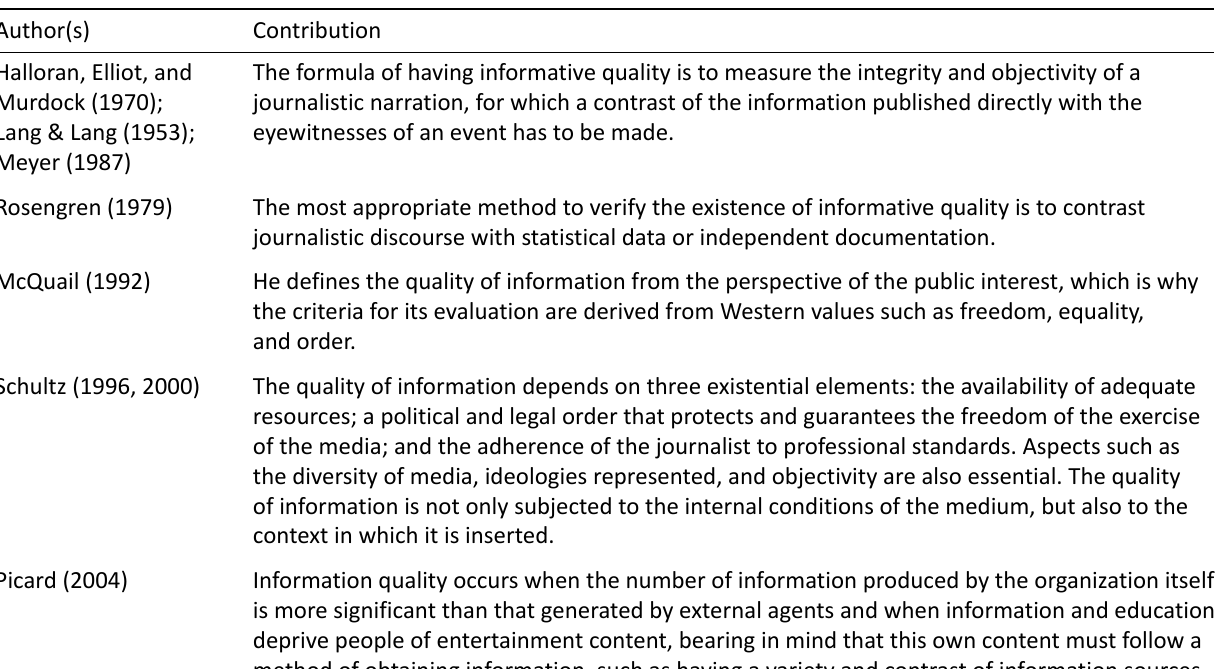
Table 1. ‘Information quality’ from the academic